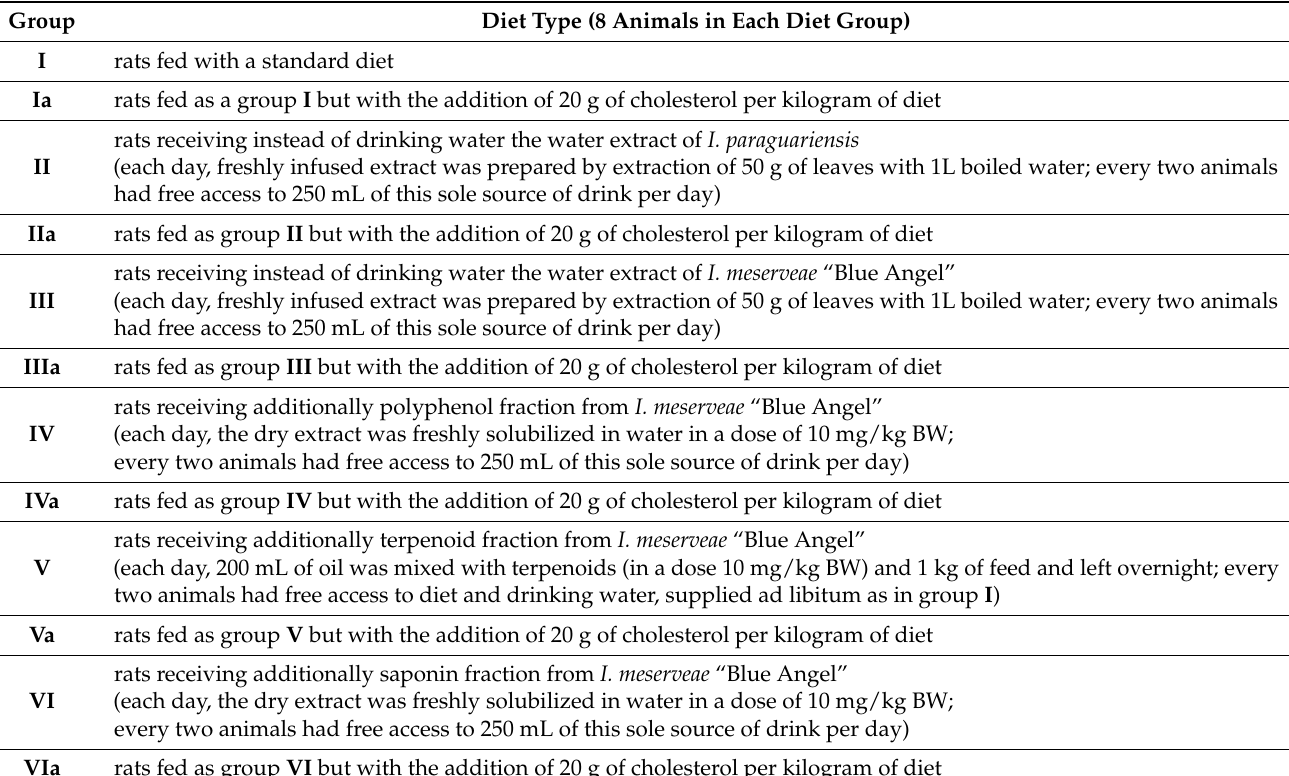
Table 1. Research groups of experimental animals. Control groups: I , Ia , and other groups with diet modified by the addition of Ilex extracts ( II – VI ) or both Ilex extracts and cholesterol ( IIa – VIa ). Group Diet Type (8 Animals in Each Diet